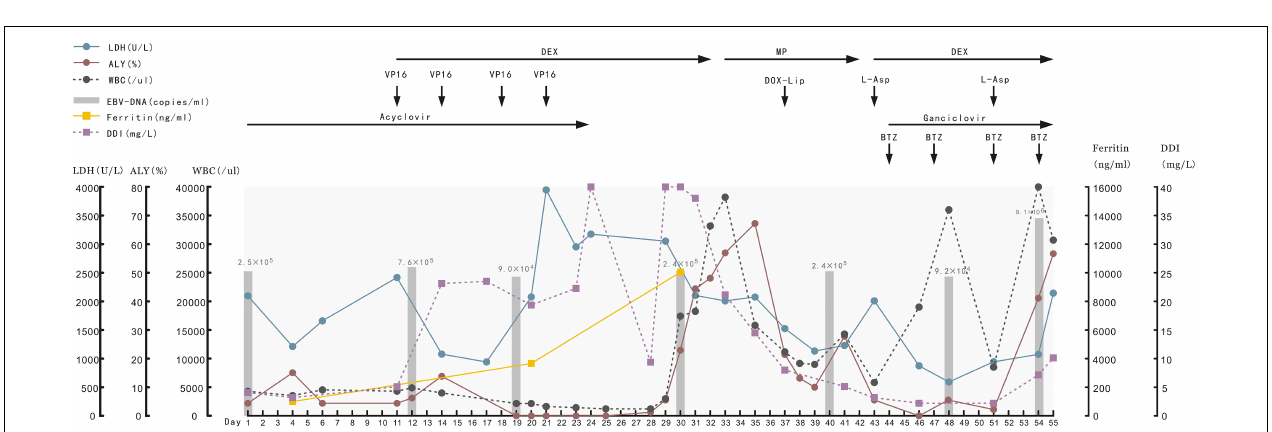
FIGURE 4 | Typical laboratory indexes of blood and the drugs used for the patient from day of admitting, she died 55 days later. LDH, lactic dehydrogenase; ALY, atypical lymphocyte; WBC, white blood cell; DDI, D-Dimer; DEX, dexamethasone; MP, methylprednisolone; VP16, etoposide; DOX-lip, doxorubicin liposomes; L-Asp, L-asparaginase; BTZ,